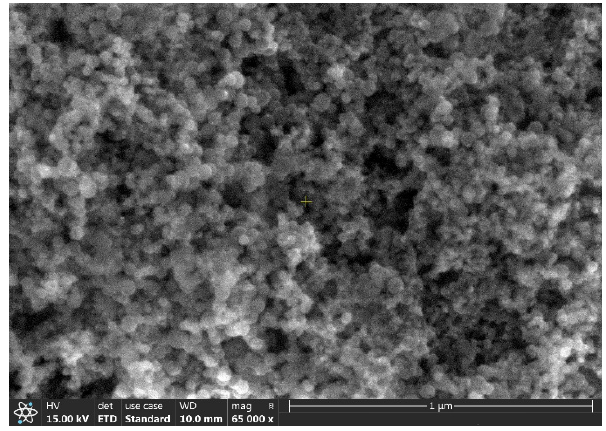
Figure 1. SEM image of Si nanoparticles from the corresponding Si nanofluids after drying.